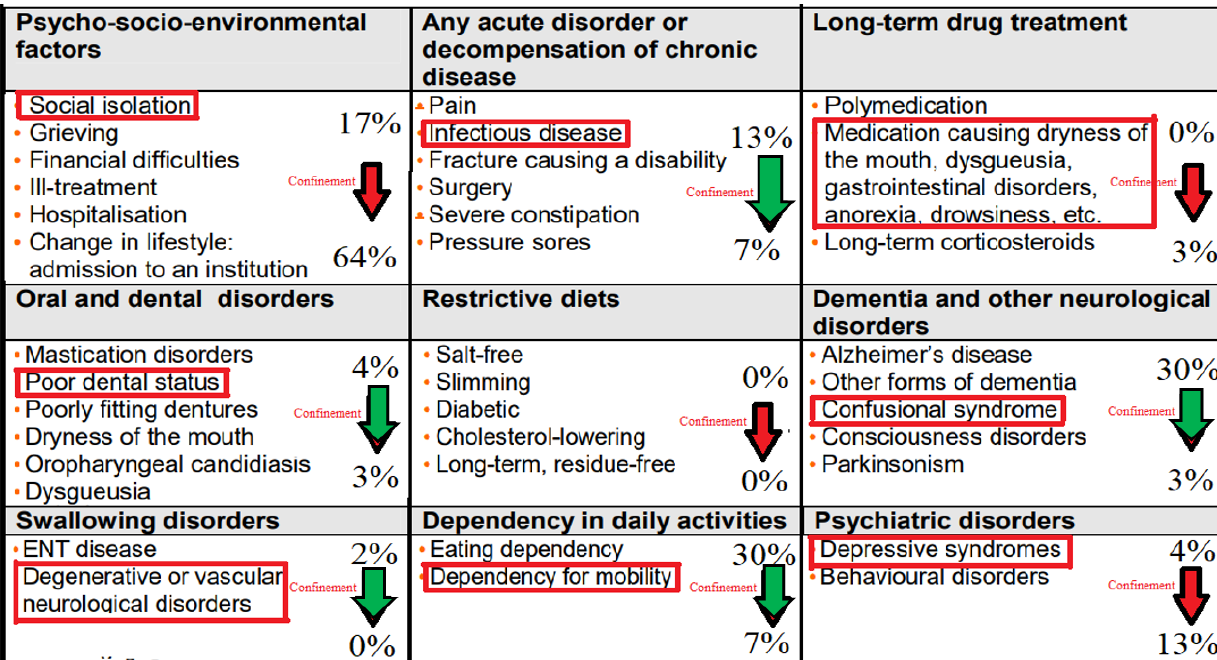
Figure 5. Trigger factors for malnutrition in the elderly, and percentage of prevalence before and after the confinement.